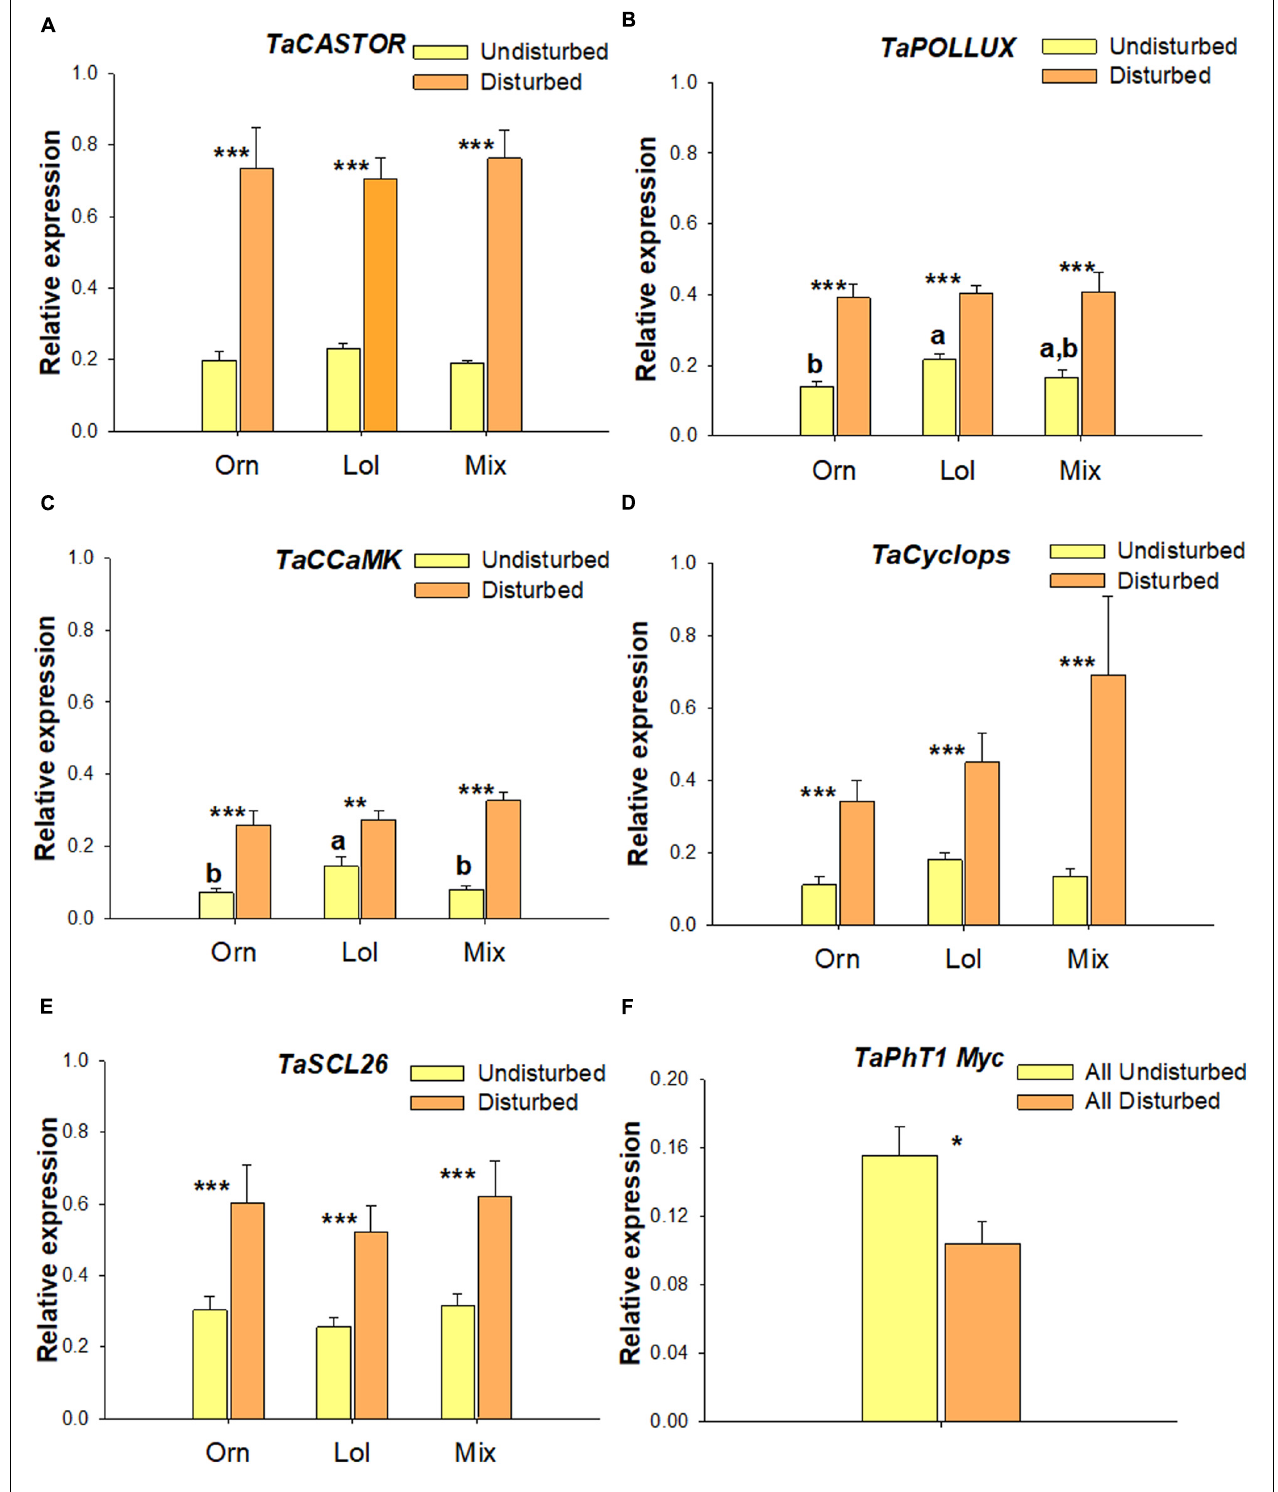
FIGURE 5 | Expression of CASTOR , POLLUX , CCaMK, Cyclops , SCL26 ( NSP2 ) and PhT1 Myc genes in wheat roots. Expression of wheat TaCASTOR (A) , TaPOLLUX (B) CCaMK (C) , TaCyclops (D) , TaSCL26 ( NSP2 ) (E), and TaPhT1 Myc (F) as determined by RT-qPCR. ∗ P < 0.05, ∗∗∗ P < 0.001 indicate significant differences between undisturbed and disturbed treatments, and a , b between different previous AMF hosts ( P < 0.05). Error bars indicate the standard error of the mean. Previous hosts: Orn, O. compressus ; Lol, L. rigidum ; Mix, O. compressus, L. rigidum grown in a mixture.